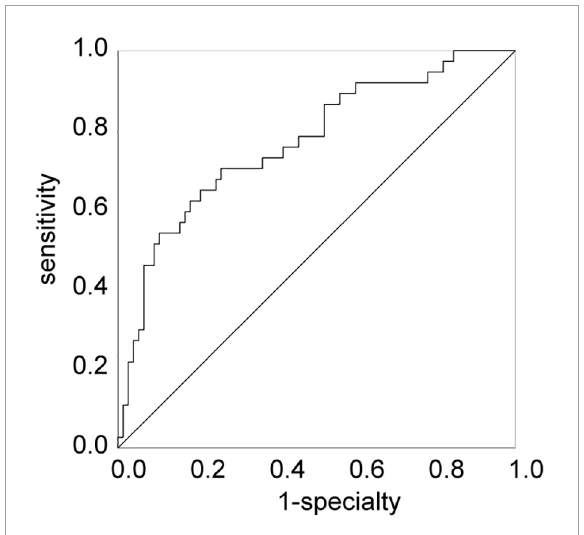
FIGURE2 The ROC curve of the multivariable logistic regression model. ROC, receiver operating characteristics